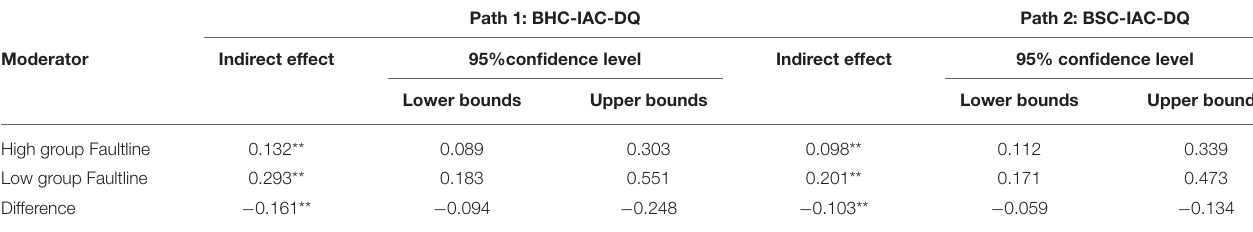
TABLE 5 | Moderated mediating